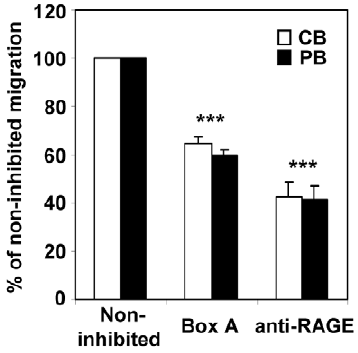
Figure 7. BoxA or anti-Rage antibody partially inhibits monocytes migration. Fresh mononuclear cells isolated from CB and PB have been added to upper well of transwell chamber to measure cell migration induced by pre-conditioned medium generated from the culture of CB or PB cells after 14 days of IL-2 treatment. The migration of monocytes (CD14 + cells) into lower chamber has been evaluated by FACS analysis. Noninhibited migration was defined as 100%. Bars represent mean 6 SD of three different experiments. The inhibition of monocytes migration has been obtained by adding BoxA or anti-RAGE antibody in upper well of transwell chamber (***P , 0.001).